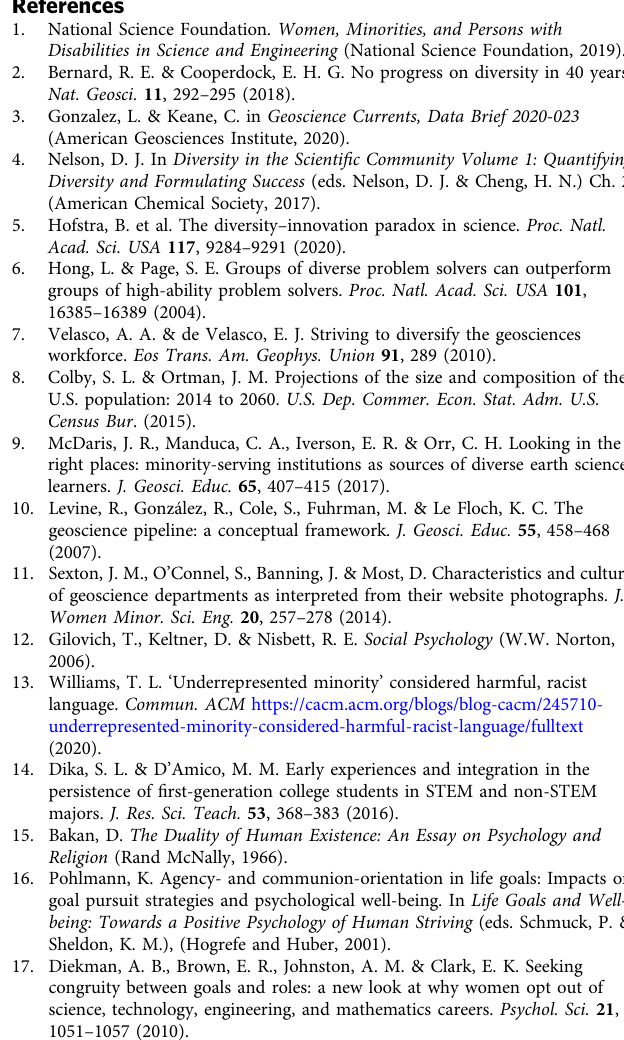
Supplementary Table 5 and Supplementary Fig. 7. The university institutional review board (IRB) at The University of Texas of Arlington approved all study procedures (IRB#